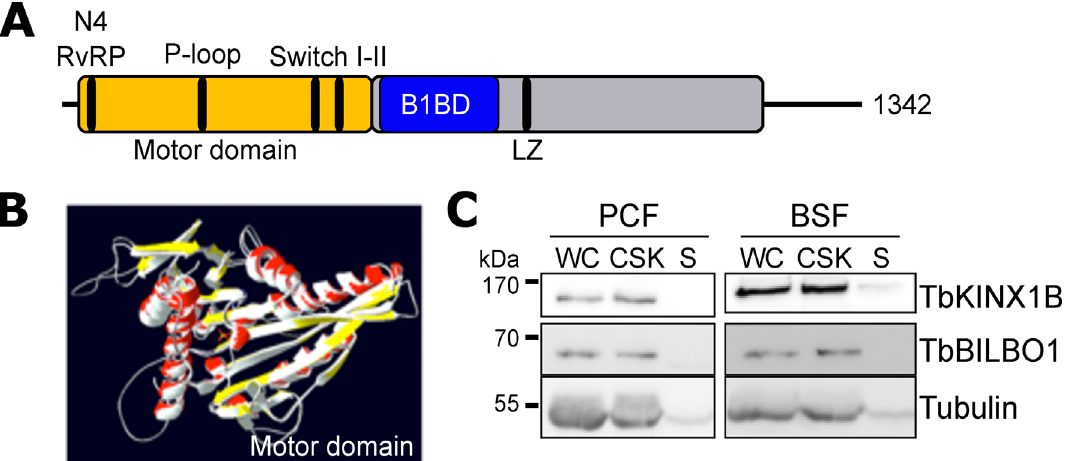
Figure 1. TbKINX1B is an N-kinesin with a classical motor domain . A. Predicted secondary structure representation of TbKINX1B protein. The kinesin motor domain (TbKINX1B MD aa. 4-496 with P-loop aa. GQTGSGKT, Switch I aa. NEHSSRSH and Switch II aa. DLAGSE), TbKINX1B leucine zipper (LZ, aa. 756 – 784), the coiled-coil (aa. 1082 – 1297), and the TbBILBO1-binding domain (B1BD aa. 517 – 715) are shown. B. Alignment-based homology model of TbKINX1B motor domain to Mus musculus KIF1A motor domain (PDB 1I5S) by Phyre2 software. The predicted tertiary structure is represented as a superposition of both kinesin motor domains, TbKINX1B (colored: yellow for b -sheet and red for a -helix) and KIF1A (white), corresponding to 100% match. C. Western blot analysis of TbKINX1B in PCF and BSF cells. TbKINX1B, TbBILBO1 and Tubulin were probed on whole cells (WC), detergent-extracted cytoskeleton (CSK) and soluble fraction (S) of lysed